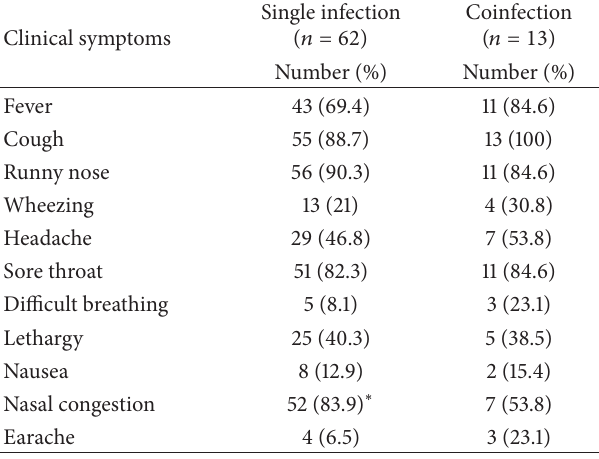
Table 5: Clinical symptoms in patients with single infections and